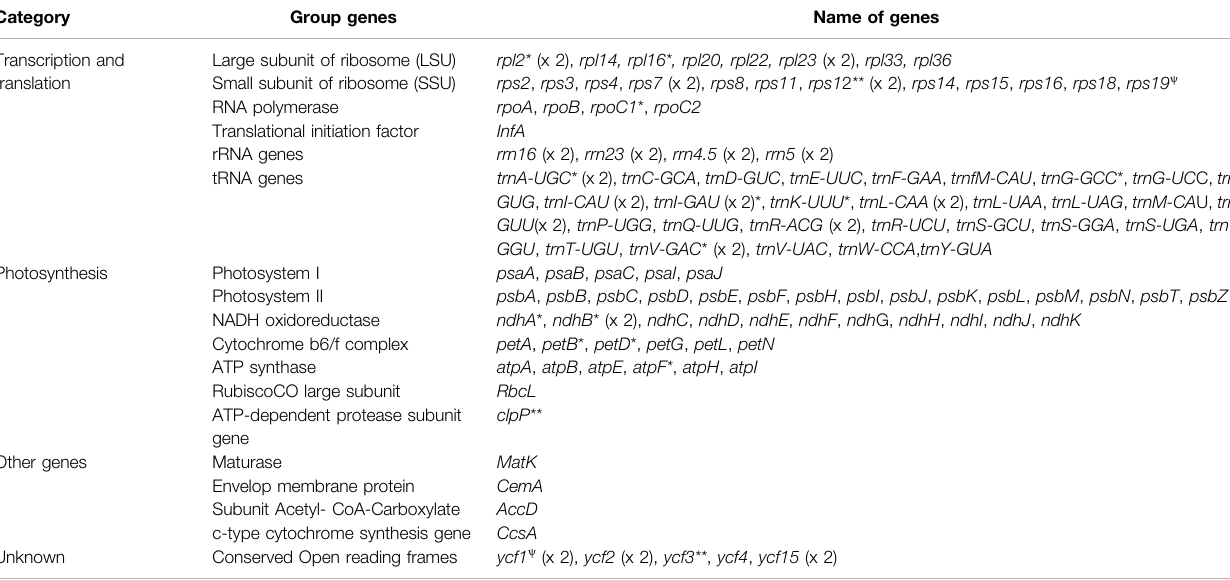
TABLE 4 | List of genes in the chloroplast genome of ten Aconitum species.